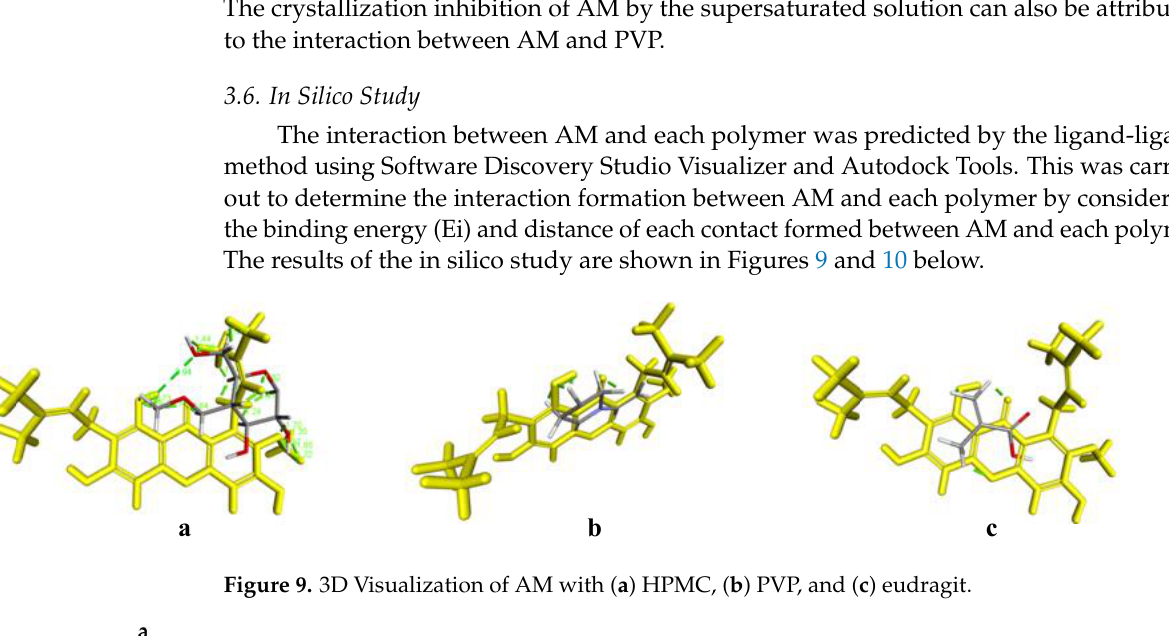
Figure 10. 2D Visualization of AM with ( a ) HPMC, ( b ) PVP, and ( c ) eudragit.